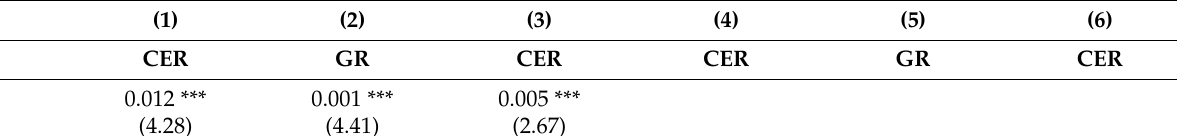
Table 5. The results of mediating effect